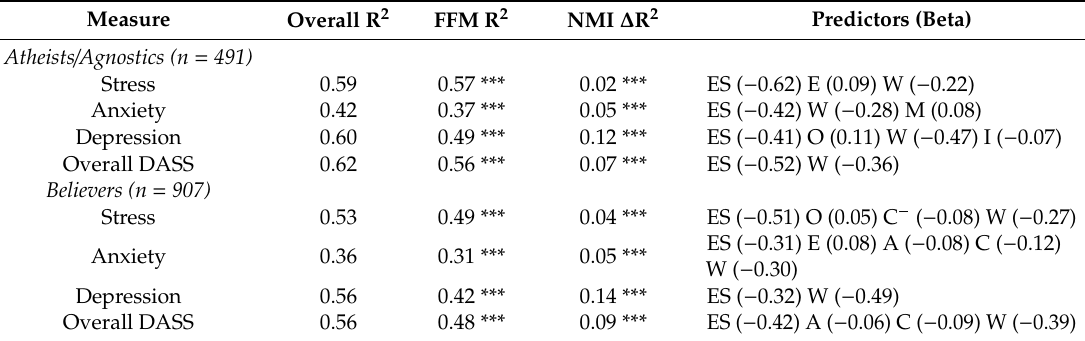
Table 4. Incremental Validity of the NMI Scales over the Five-Factor Model (FFM) Domains in Predicting Emotional Distress on the DASS for Atheist / Agnostics and Other Faith